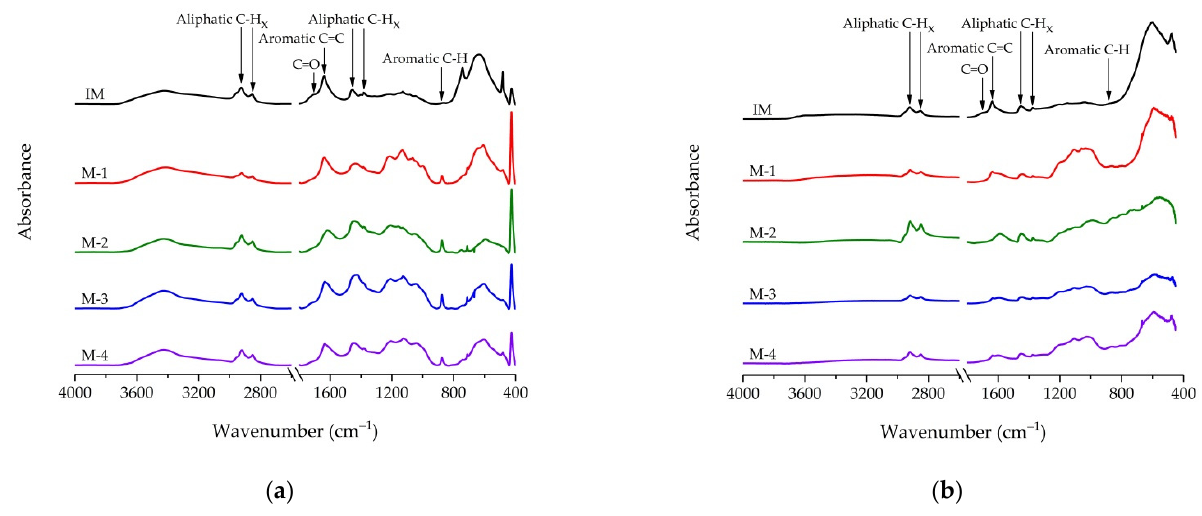
Figure 1. FTIR spectra of the Bazhenov formation kerogen samples from Krasnoleninskiy Arch (M-1–M-4) and Nyurolskaya Depression (IM): ( a ) in transmission mode (0.1% kerogen at KBr pellet); ( b ) in ATR mode.